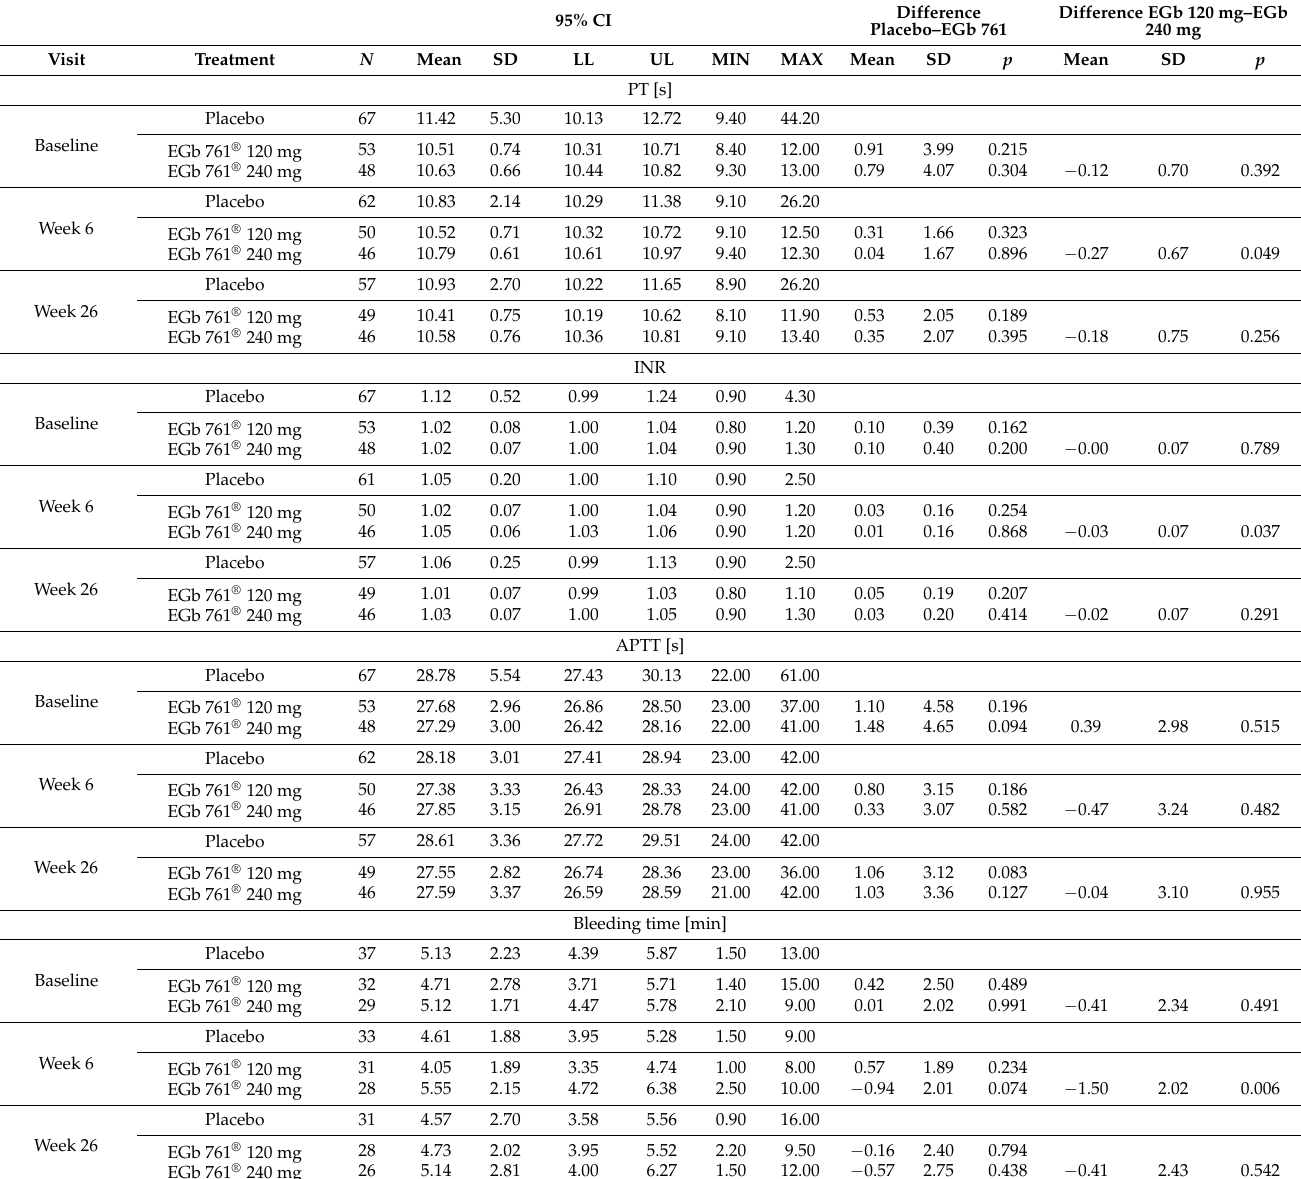
Table 3. Coagulation parameters and bleeding time of patients taking acetylsalicylic